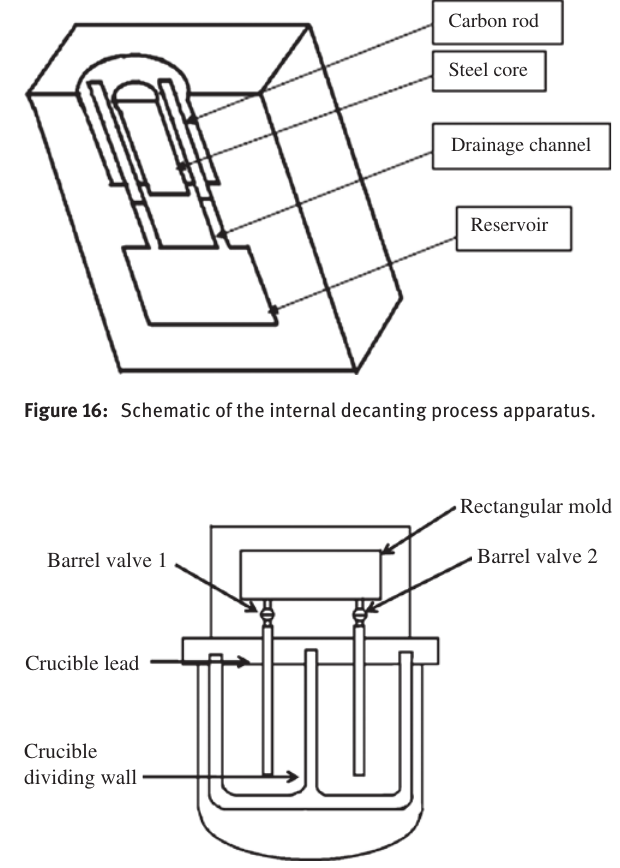
Figure 17: Schematic of the low-pressure casting